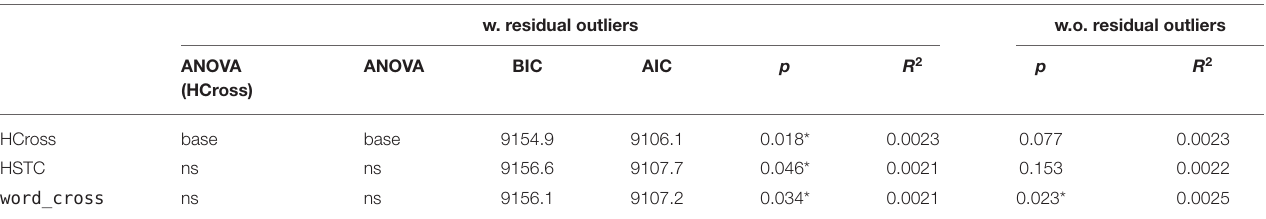
TABLE 1 | Summary of effects on First Fixation Duration